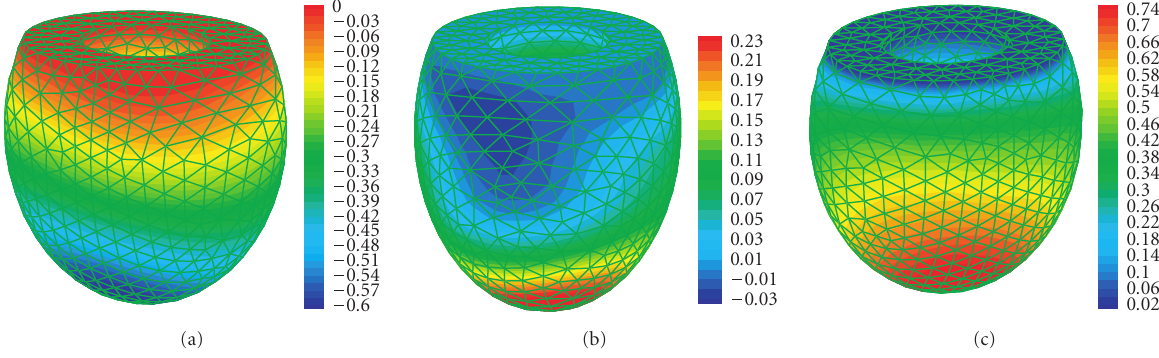
Figure 7: Di ff erences between dynamic and static displacements on the epicardial surface, at t = 0 . 45 second. (a) Displacement component u x ; (b) u y ; and (c) u z . View angles and contour levels are chosen for best